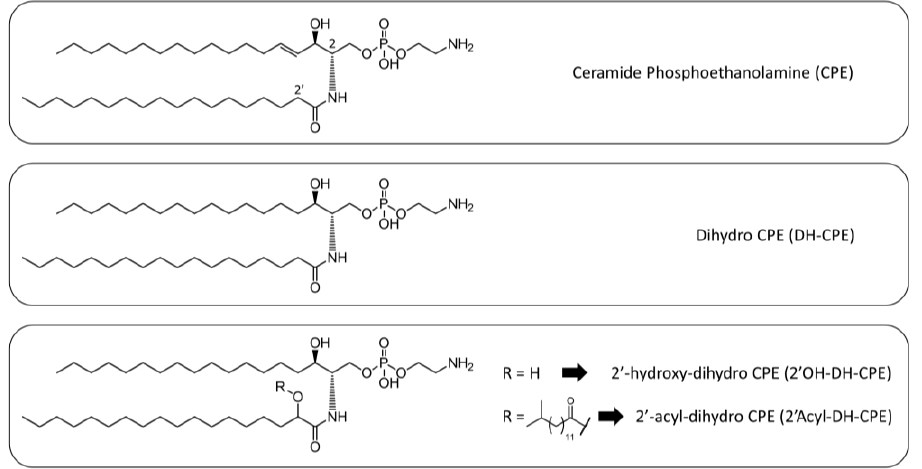
Figure 3. Structures of CPE analogues isolated from Tannerella forsythia . A CPE is shown at the top; a reduced dihydro CPE in the middle (DH-CPE); and a 2′ -hydroxylated or 2′ -acylated DH-CPE reduced dihydro CPE in the middle (DH-CPE); and a 2 (cid:48) -hydroxylated or 2 (cid:48) -acylated DH-CPE (2 (cid:48) OH- ( 2′ OH- or 2′ -acyl-DH-CPE) at the bottom. or 2 (cid:48) -acyl-DH-CPE) at the bottom.